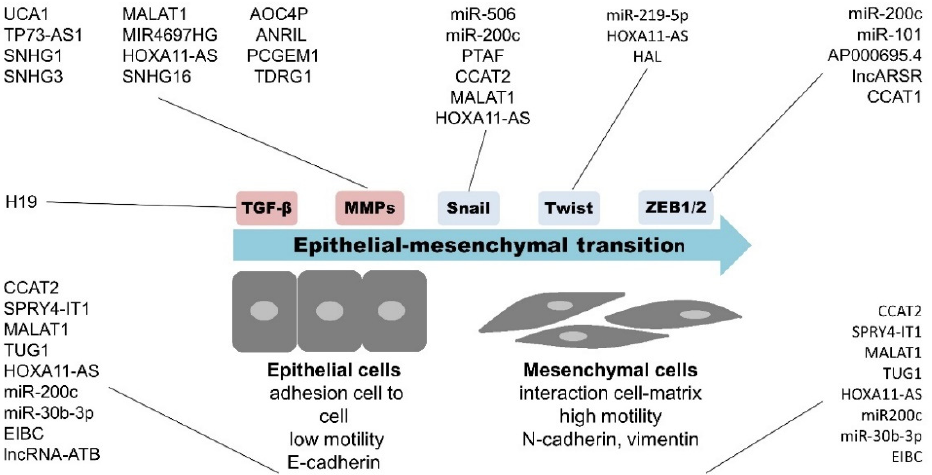
Figure 3. Schematic representation of ncRNA influencing epithelial–mesenchymal transition (EMT) process in OC. This chart shows ncRNAs elements—miRNAs and lncRNAs, which associate with EMT regulation. During EMT, adherent epithelial cells are changed to highly motile mesenchymal cells, capable of invading other places in human body. Few key molecules, i.e., E-cadherin, N-cadherin, and vimentin, whose expression is regulated by miRNAs and lncRNAs, characterize this process. Several ncRNAs regulate/interact with EMT-transcription factors (Snail, Twist, and ZEB families) and thus affect the EMT process. Other key players in EMT regulated by ncRNA are metalloproteinases (MMPs) and TGF- β .